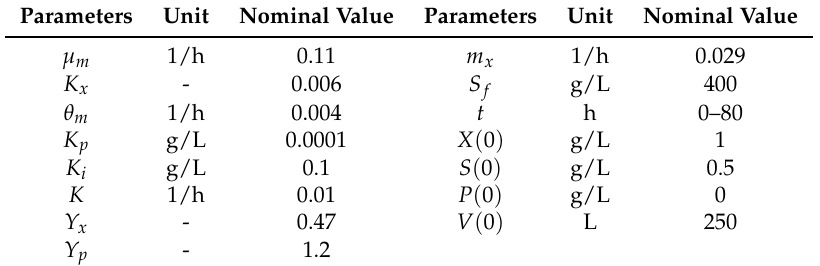
Table 3. Nominal values of the model parameters and the initial conditions for the fed-batch model.